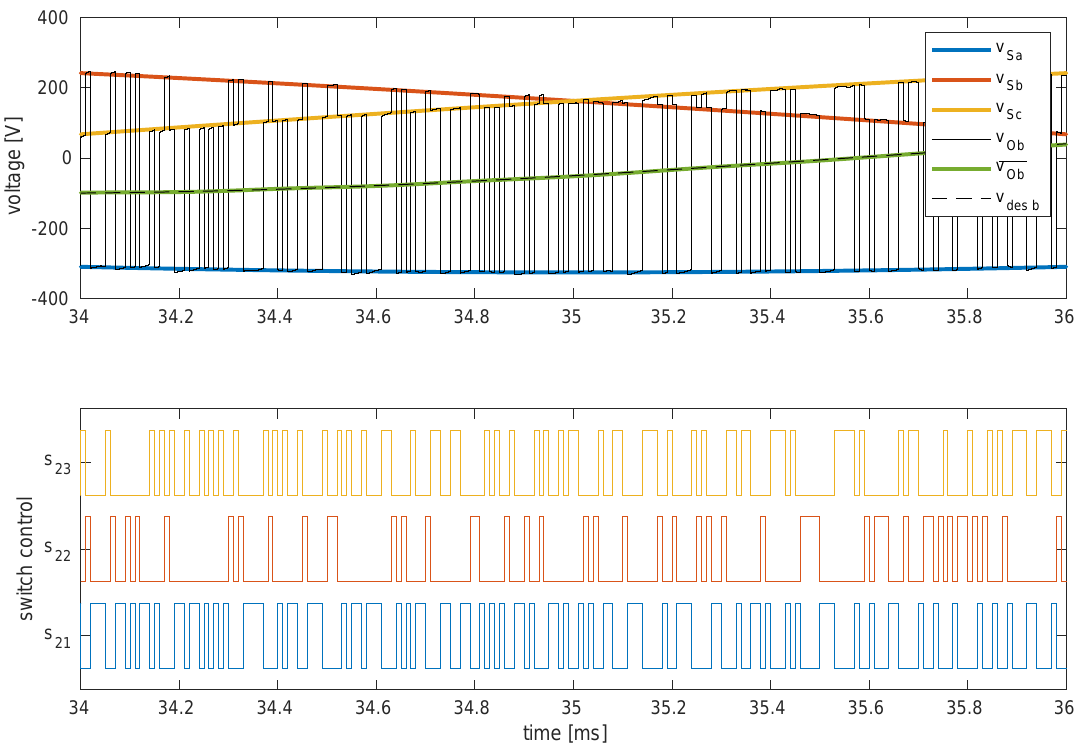
Figure 3. Example of the switching sequence obtained by the sigma-delta